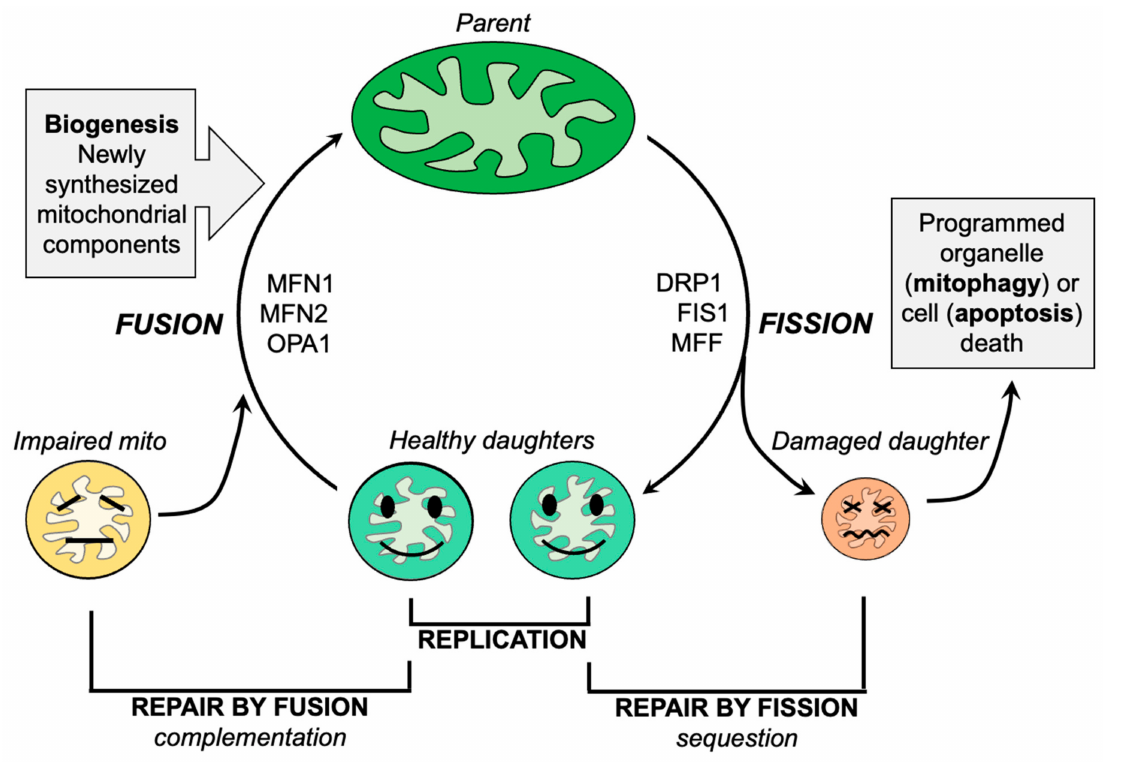
Figure 2. Schematic depiction of the roles of mitochondrial fission and fusion in maintaining mito- chondrial